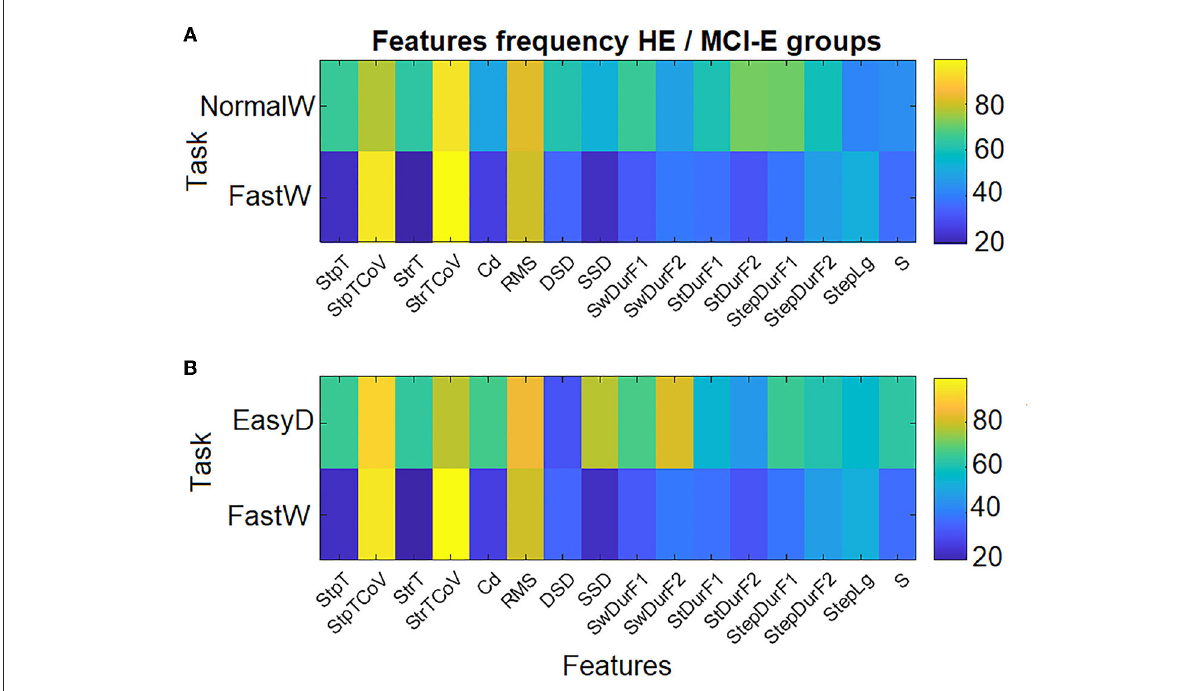
FIGURE6 The proportion of time (%) each measure appeared as significantly for two estimated models across iterations: (A) NormalW + FastW and (B) EasyD + FastW.